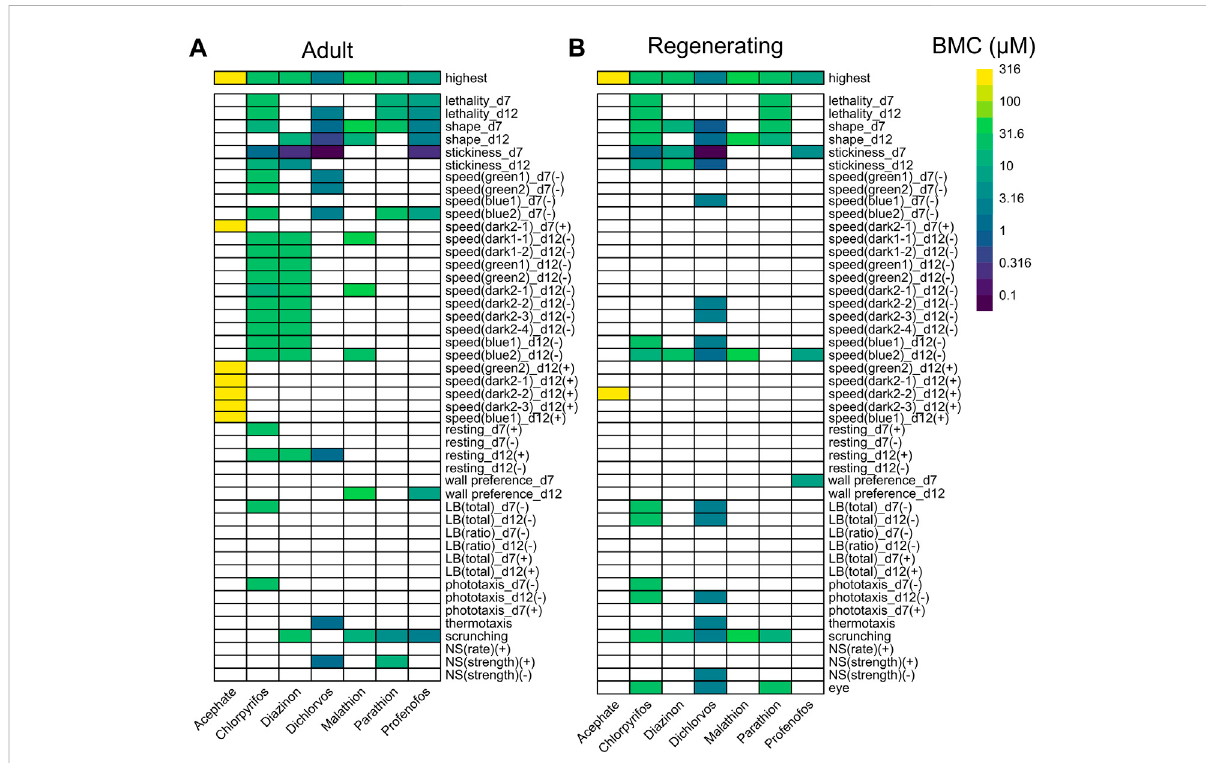
FIGURE 1 Comparison of OP toxicity. Heatmaps comparing the benchmark concentrations (BMCs) for the OPs in adult (A) and regenerating (B) planarians. The fi rst row shows the highest tested concentration. For outcome measures that can have effects in both directions, the BMCs are separated by either the positive (+) or negative (-) direction. For readability, speed endpoints that were inactive in both adult and regenerating planarians are not shown. LB: locomotor bursts; NS: noxious